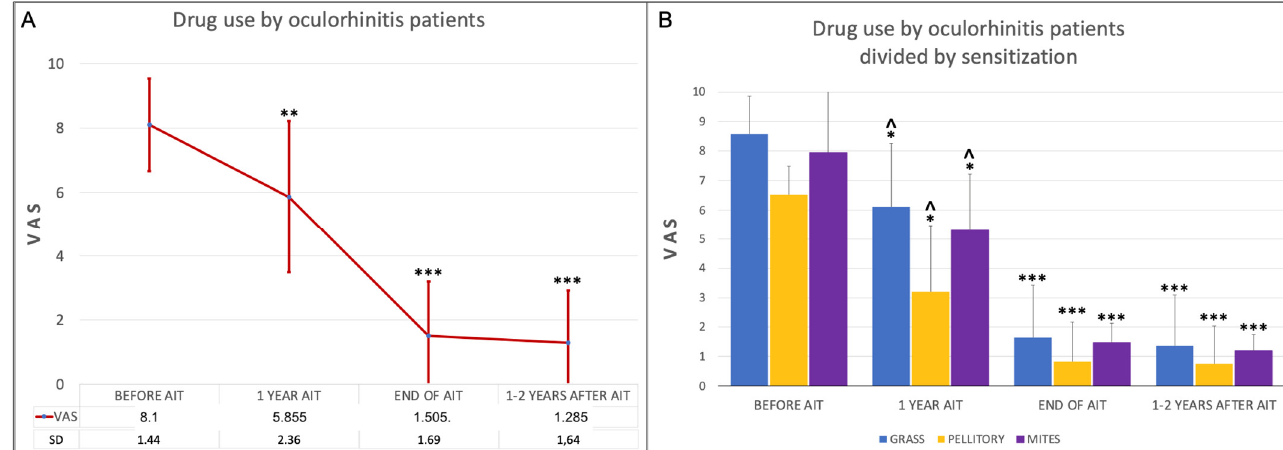
Figure 2. ( A ). VAS for the use of oral and systemic antihistamines and corticosteroids by all patients with oculorhinitis (265) over the course of AIT. A significant decrease was observed comparing the various phases of AIT with respect to before the treatment. ^ p < 0.01 Wilcoxon test comparing VAS changes at 1 year AIT respect before. * p < 0.001 Friedman test detecting differences across the course of AIT. ( B ). Drug consumption (systemic and local antihistamines and steroids) by oculorhinitis patients divided by allergic sensitization over the course of AIT. ˆ p < 0.05 Wilcoxon test comparing VAS changes at 1 year AIT with respect to before treatment. * p < 0.01; ** p < 0.05; *** p < 0.001 Friedman test detecting differences across the course of